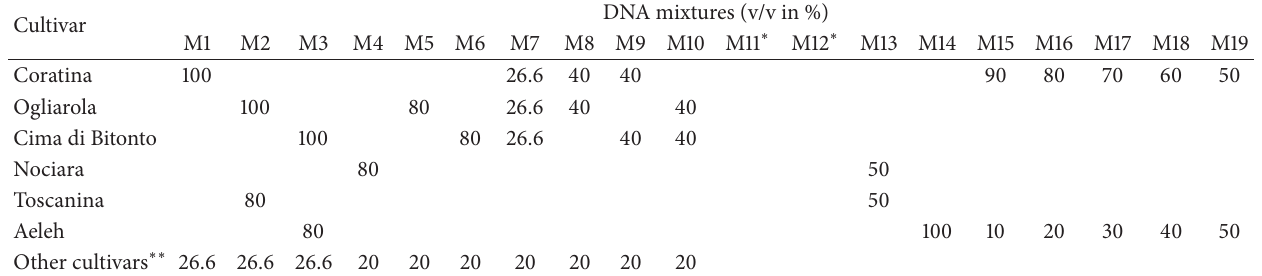
Table 2: Composition of the mixtures of DNA olive oil used in HRM